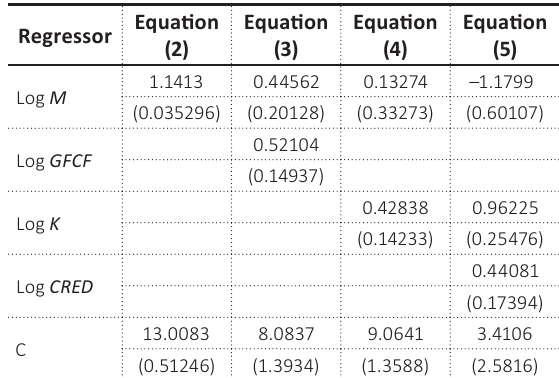
Table 6. Error correction representation for the ARDL